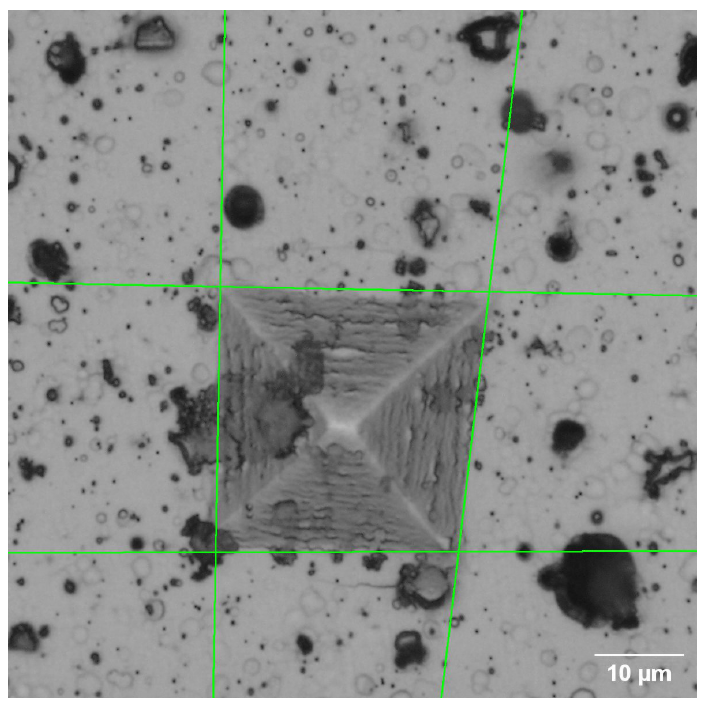
Figure 10. Result of corner